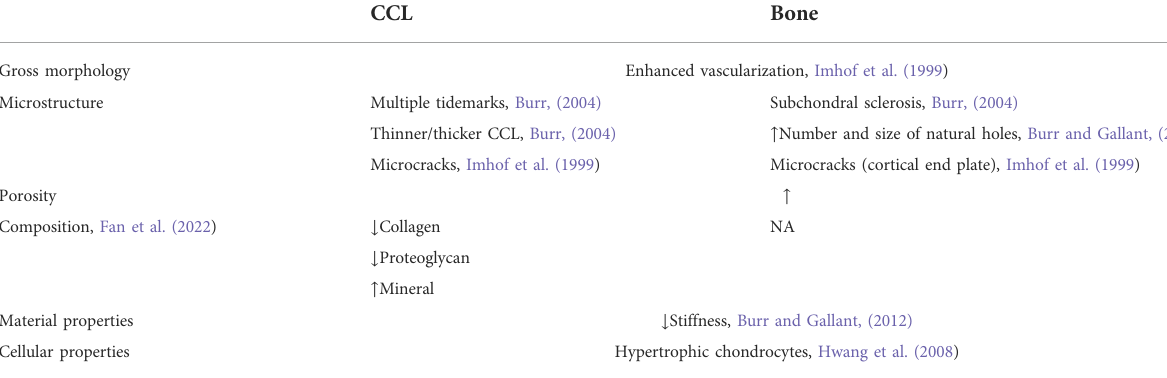
TABLE 2 Changes of CCL and subchondral bone in different levels in OA